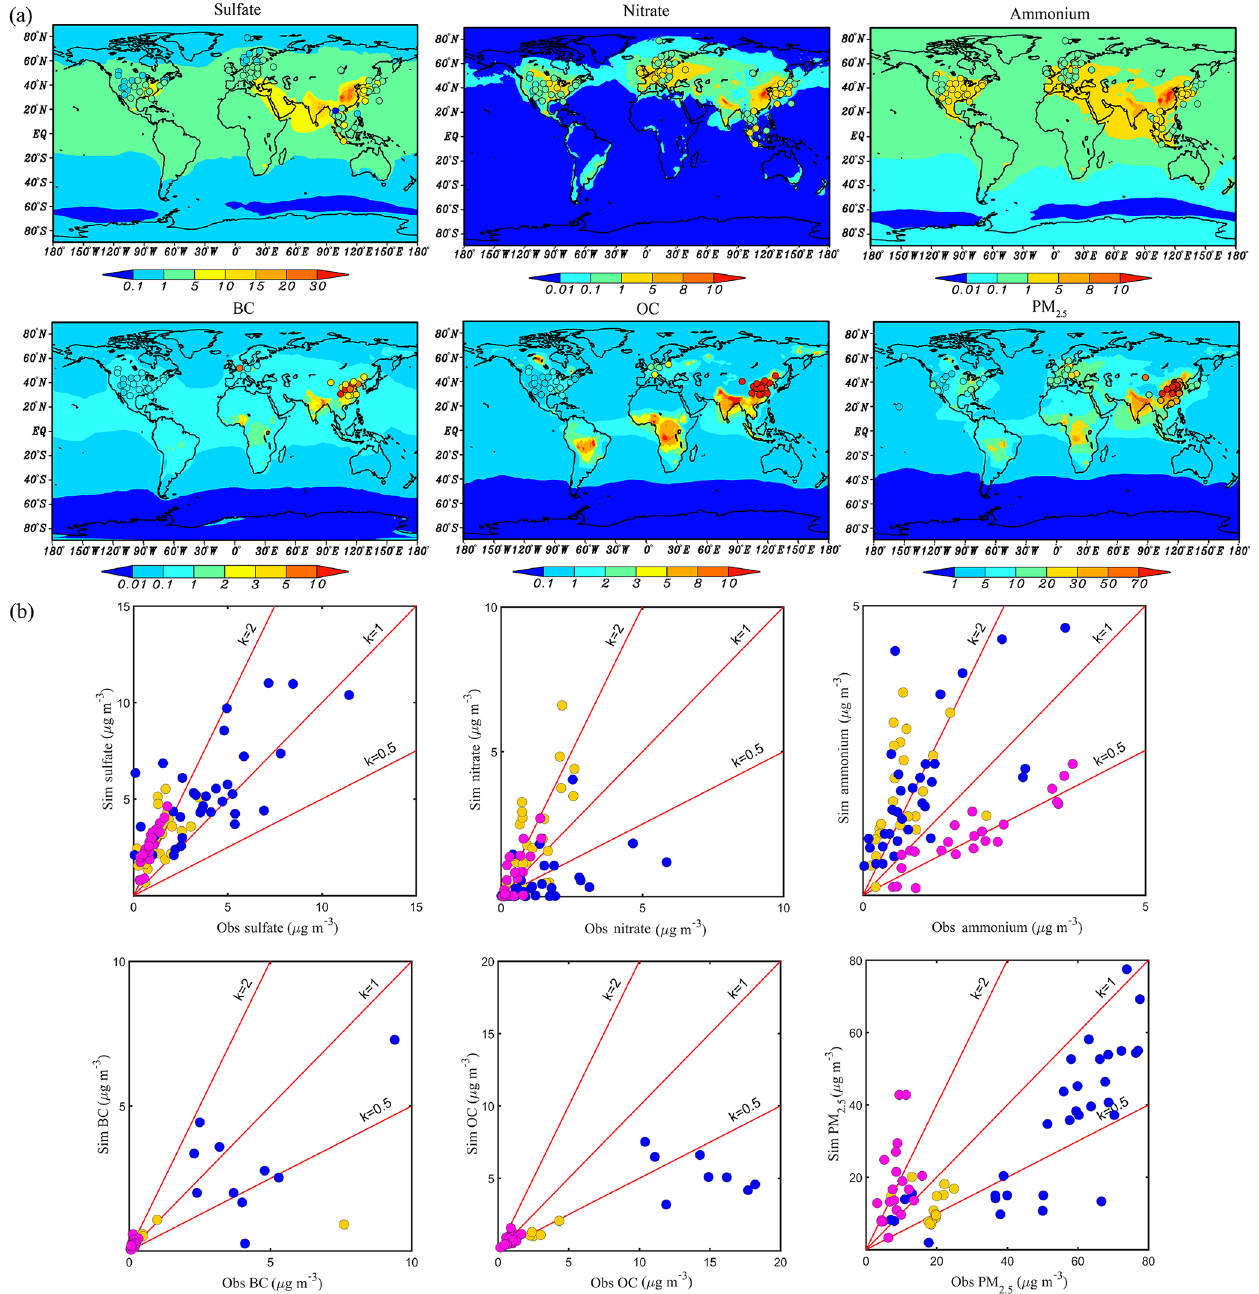
Figure 7. (a) The same as Fig. 4, except for sulfate, nitrate, ammonium, BC, OC, and PM 2 . 5 (in µgm − 3 ). The top row is sulfate, nitrate, and ammonium, and the bottom row is BC, OC, and PM 2 . 5 . (b) Scatterplot of annual mean concentration. The order of the plots in (b) are in accordance with panel (a) . Solid circles in blue, yellow, and magenta represent Asia, Europe, and NAmerica